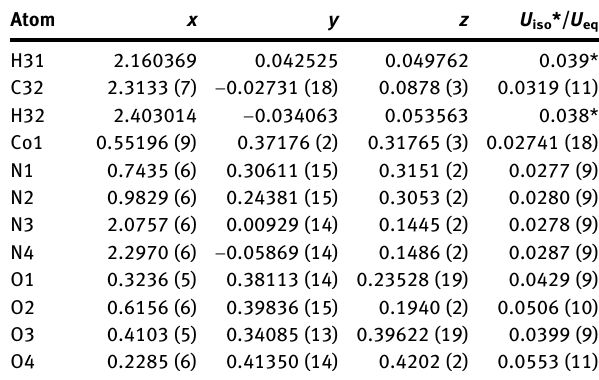
Table  : Fractional atomic coordinates and isotropic or equivalent isotropic displacement parameters (Å 